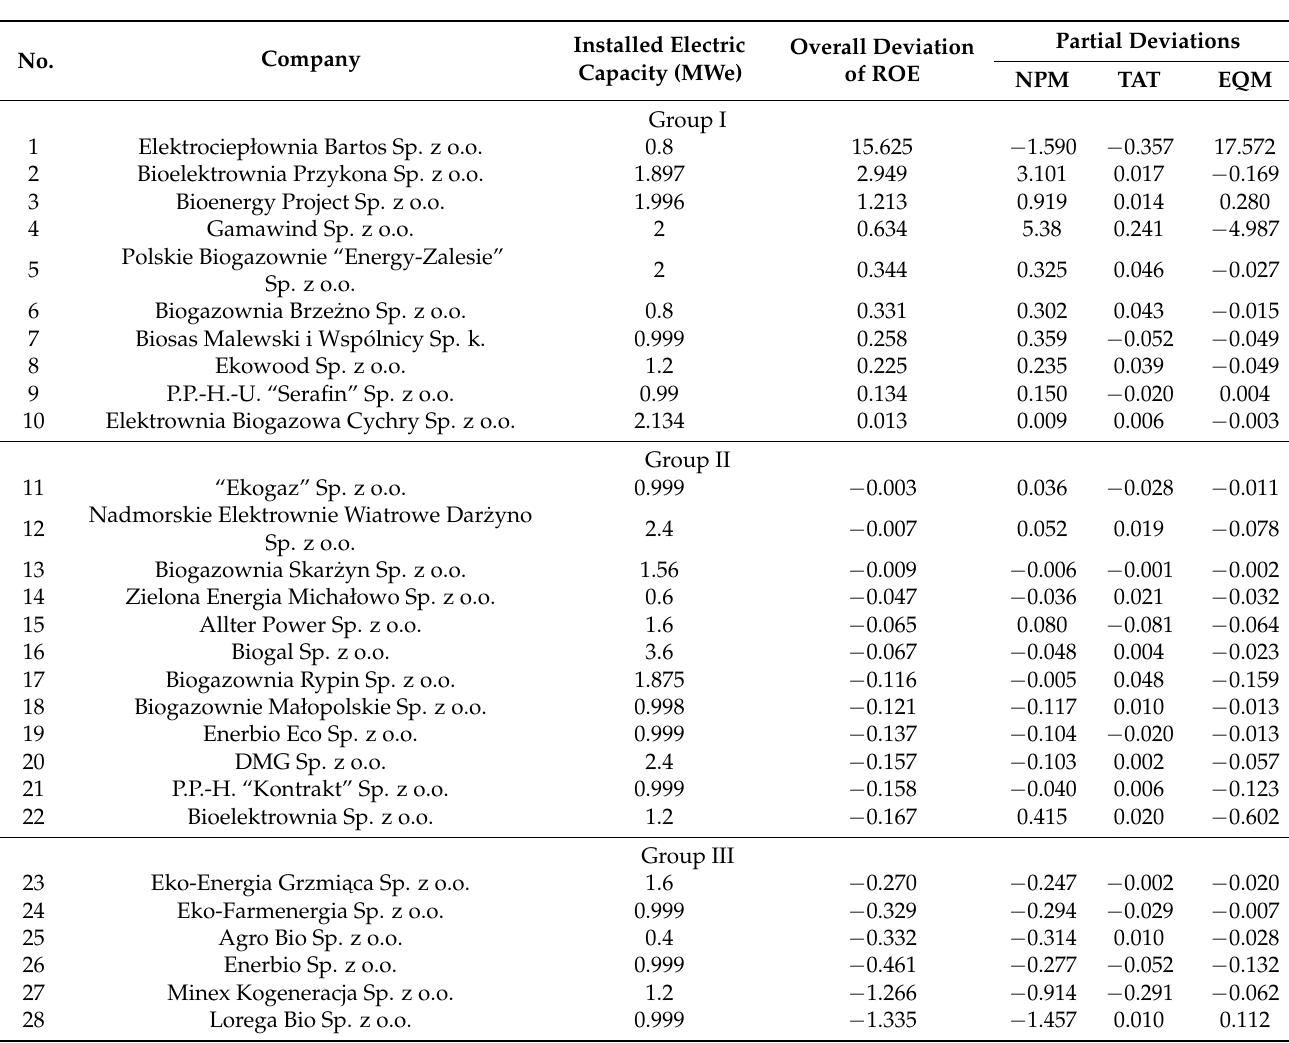
Table 1. Results of causal analysis using the Du Pont model for